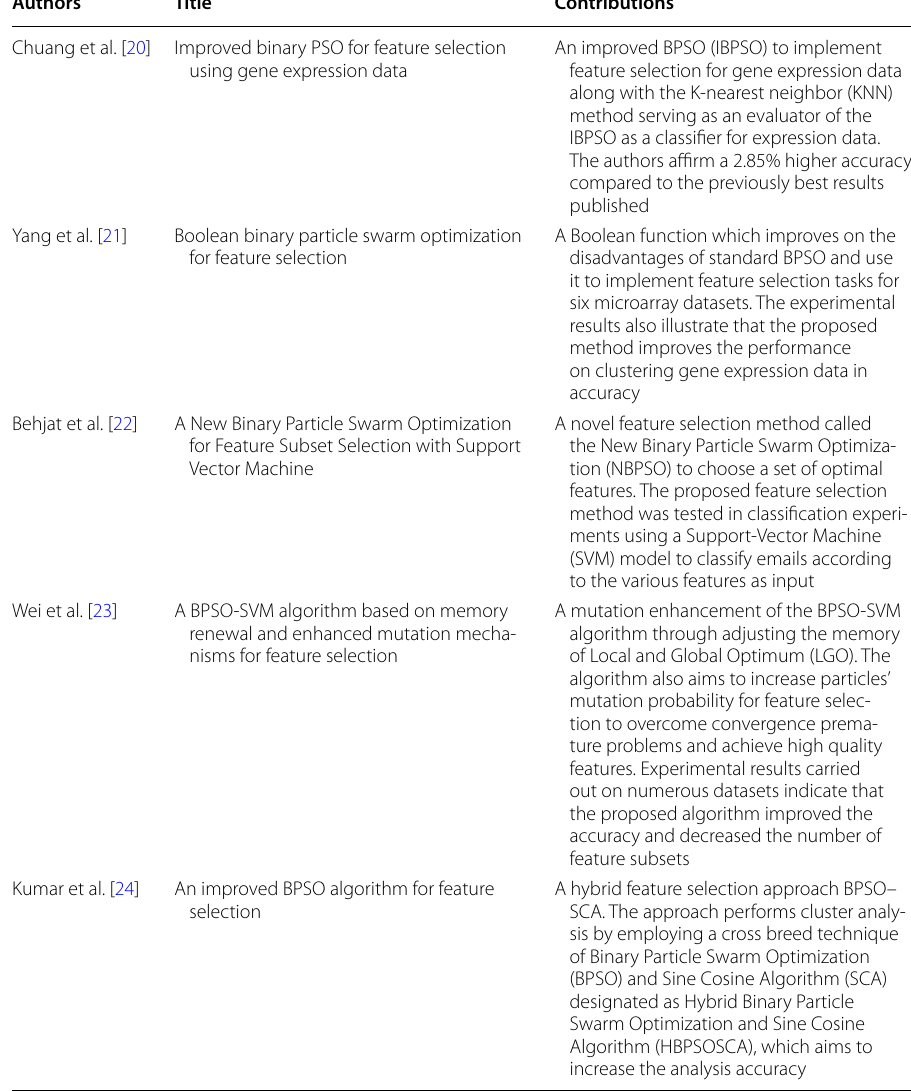
Table 2 BPSO based feature selection methods